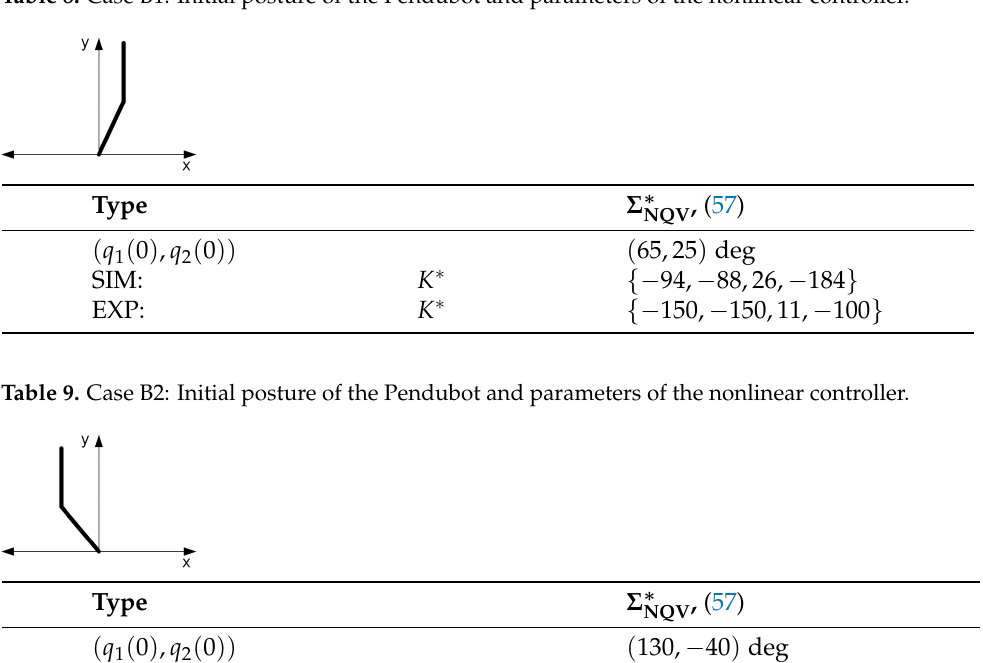
Table 8. Case B1: Initial posture of the Pendubot and parameters of the nonlinear controller.